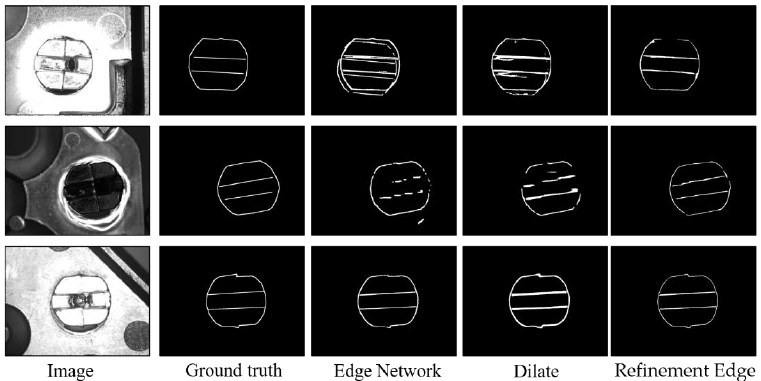
Figure 11. Comparison of the results of ablation experiments.